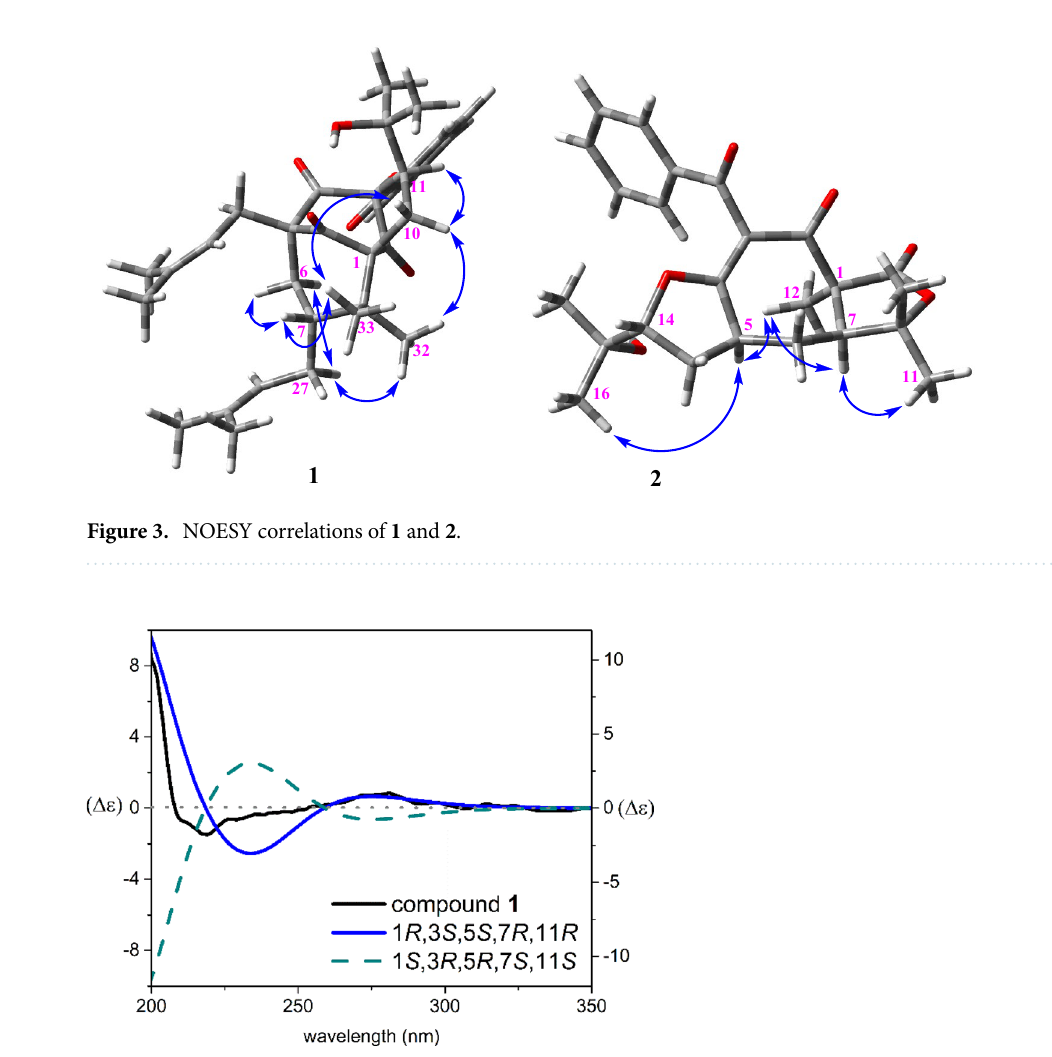
Figure 4. Comparison of experimental and TDDFT calculated ECD spectra of 1